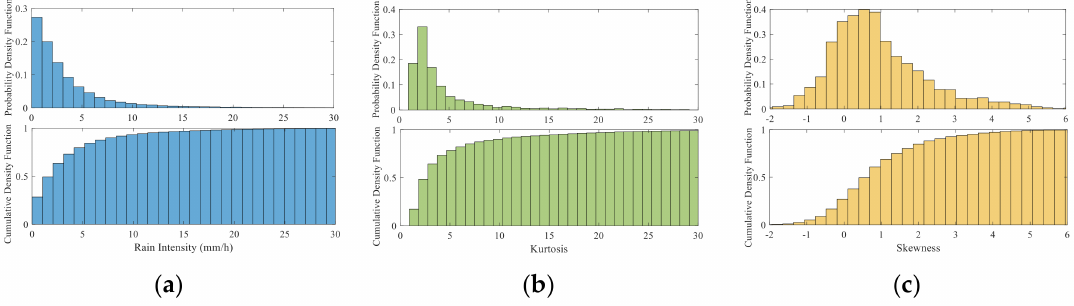
Figure 12. The probability density function and cumulative density function of ( a ) rain intensity, ( b ) kurtosis and ( c )